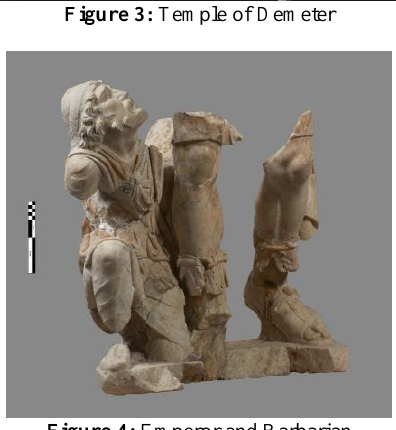
Figure 4: Emperor and Barbarian